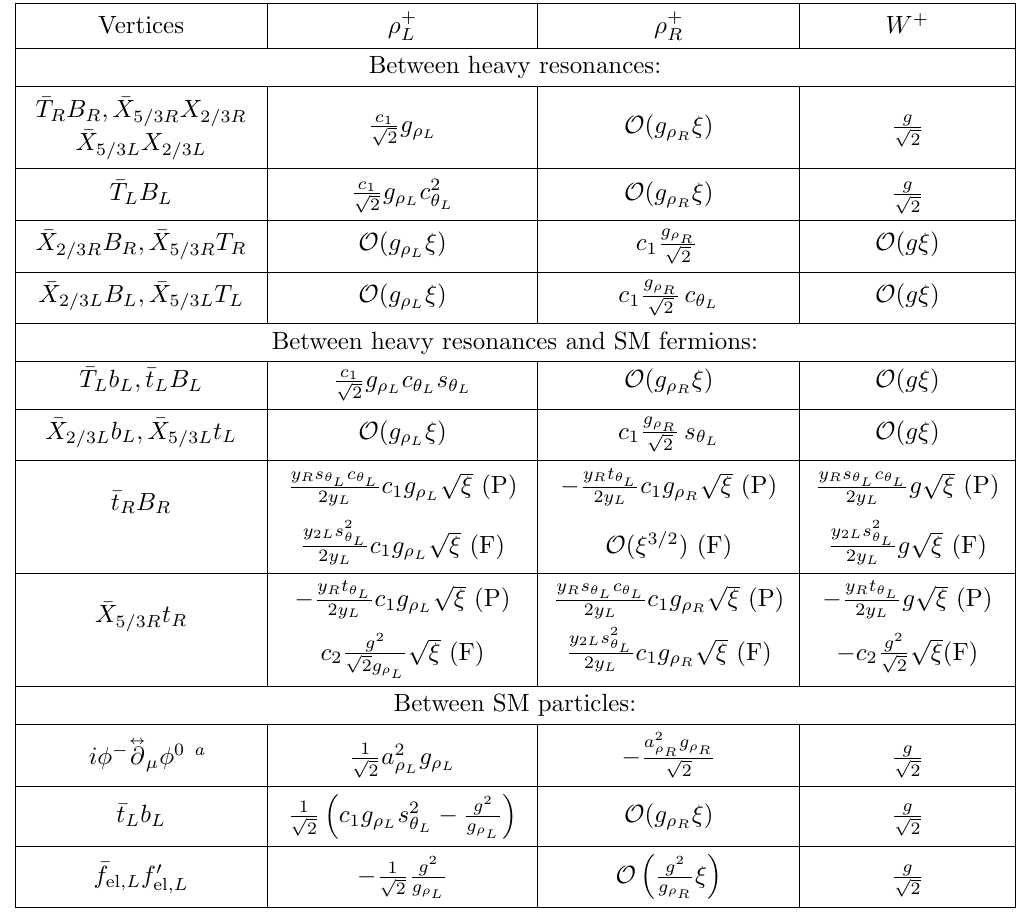
Table 2. The LO coupling strengths between the charged spin-1 bosons (cid:26) (cid:6) in models LP(F) 4 , RP(F) 4 . Note that f el denotes all the SM light fermions, including the (cid:12)rst two generation quarks, b R and all the leptons. Here (P) and (F) mean the partially and fully composite right-handed top quark scenario,